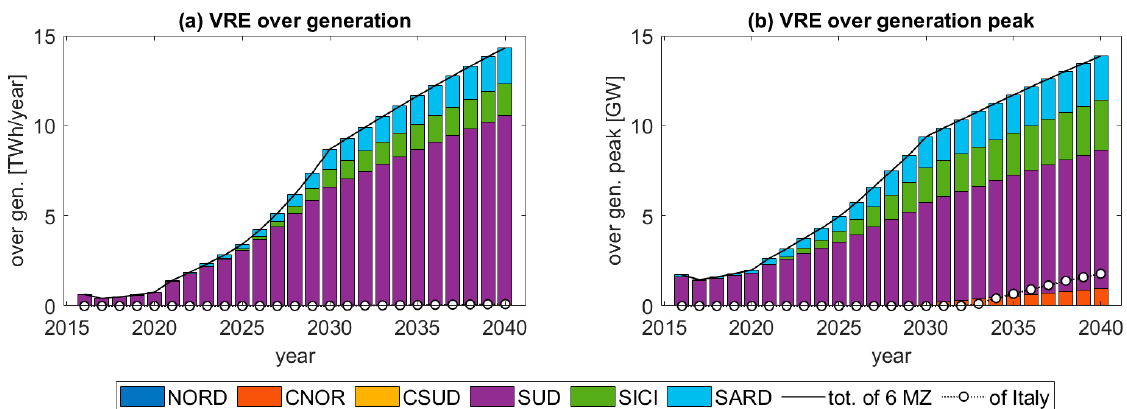
Figure 18. Current and future annual overgeneration energy and peak power under the TSO’s demand/VRE capacity growth scenario. The peak power is the 99.7% quintile of the VRE over-production occurred during a year. ( a ) VER over generation. ( b ) VER over generation